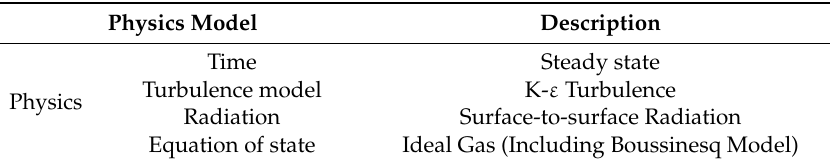
Table 3. Model of